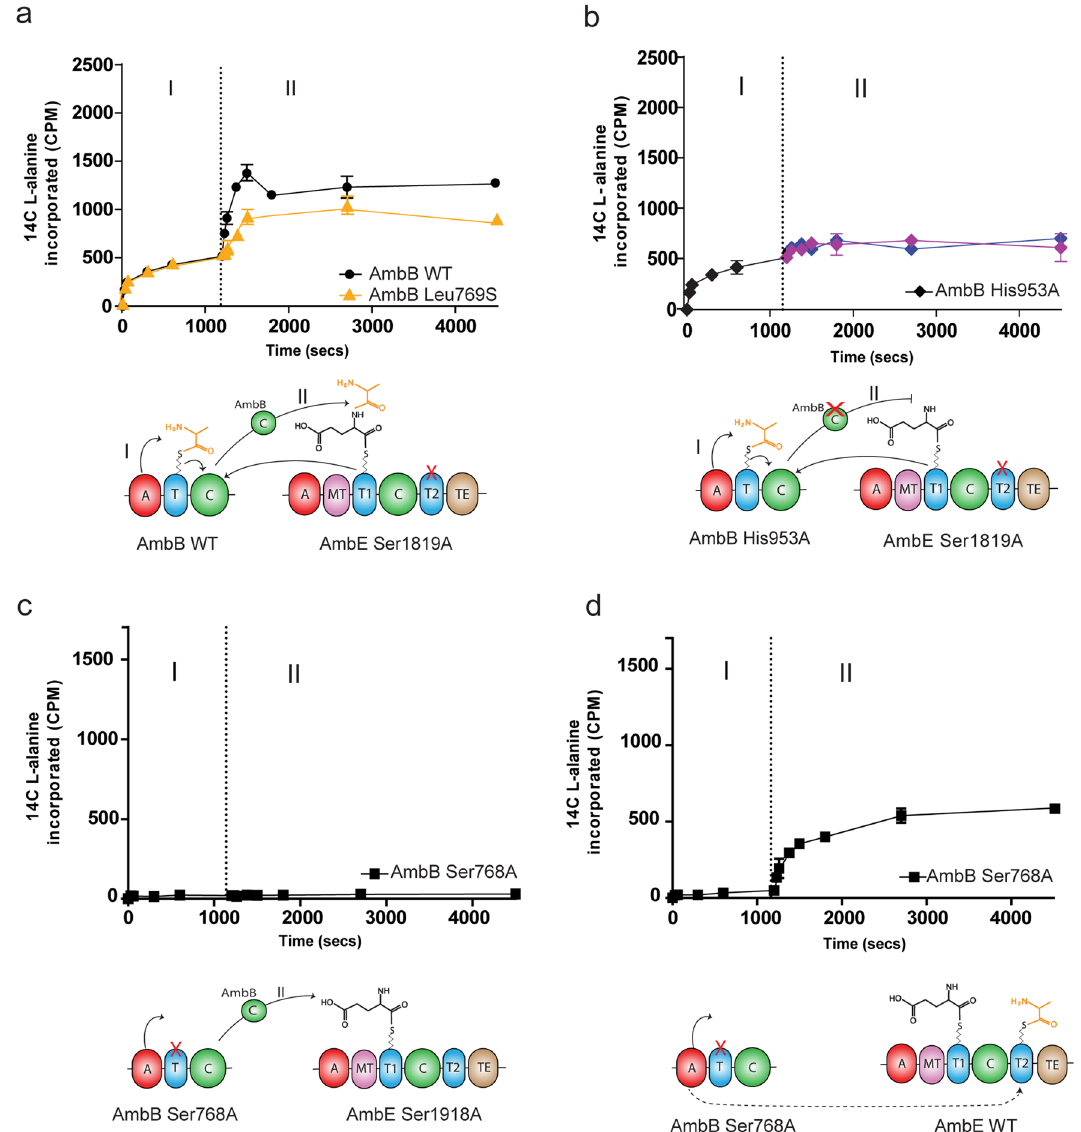
Figure 5. Time course of 14-C-l-Alanine precipitation radioassay for detection of l-Ala-l-Glu dipeptide synthesis. Product formation was initiated at 1200 s (represented by dotted line) by addition of an equimolar volume of pre-incubated AmbE S1819A with non-radiolabeled l-Glu (Stage II). ( a ) An almost doubling in 14-C-l-Alanine labeling was observed for AmbB WT which is due to dipeptide formation and rapid reloading of the T1 domain of AmbB WT. The condensation activity in mutant AmbB Leu769S is impaired as shown by the significantly decreased 14-C-l-Alanine labeling in Stage II. ( b ) Condensation activity is abolished in AmbB His953A as observed during stage II. The amount of 14-C-l-Alanine labeling for AmbB His953A with AmbE S1819A (blue line) was similar to that of AmbB His953A with buffer only (pink line). ( c ) Aminoacylation and dipeptide formation was abolished in AmbB Ser768. ( d ) Increasing l-[14C]-Ala labeling during Stage II was due to trans-aminoacylation of l-[14C]-Ala onto the T2 domain of AmbE WT by the A domain of AmbB Ser768A. The graph lines represent mean data ± SD obtained from three experiments. Any difference was considered significant at P value < 0.05 using t show a quasi-identical conformation suggesting that it does not undergo obvious conformation change upon Ppant binding, at least by its upstream T domain. In addition, the delivery of the substrate l-Ala, did not cause any discernible conformation change in the C domain. Three structures of substrate-bound C domains of NRPS have been solved 22,26,27 . In addition to C domain of LgrA which features the synthesized donor CoA-fVal 26 , two other structures show mimics of acceptor substrate loaded Ppant in the C domain of CDA synthethase 22 , and stabilised-Glycine acceptor substrate in C domain of fuscachelin synthethase, respectively 27 . It is plausible that a mixture of Ppant and Ppant-l-Ala states may exist in the crystal structure of holo AmbB T–C with l-Ala due to the thioester linkage undergoing cleavage over the course of crystallisation. The Ppant arm which is intrinsically flexible as observed by the fragmented electron